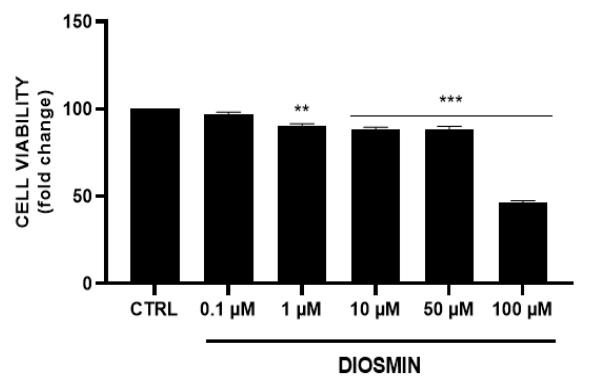
Figure 12. Assessment of diosmin effect on ARPE-19 cell viability (*** p < 0.0005, ** p < 0.005 vs. CTRL).